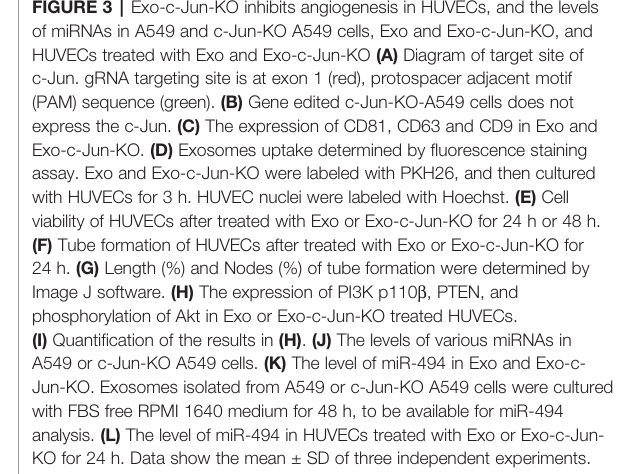
FIGURE 3 | Exo-c-Jun-KO inhibits angiogenesis in HUVECs, and the levels of miRNAs in A549 and c-Jun-KO A549 cells, Exo and Exo-c-Jun-KO, and HUVECs treated with Exo and Exo-c-Jun-KO (A) Diagram of target site of c-Jun. gRNA targeting site is at exon 1 (red), protospacer adjacent motif (PAM) sequence (green). (B) Gene edited c-Jun-KO-A549 cells does not express the c-Jun. (C) The expression of CD81, CD63 and CD9 in Exo and Exo-c-Jun-KO. (D) Exosomes uptake determined by fl uorescence staining assay. Exo and Exo-c-Jun-KO were labeled with PKH26, and then cultured with HUVECs for 3 h. HUVEC nuclei were labeled with Hoechst. (E) Cell viability of HUVECs after treated with Exo or Exo-c-Jun-KO for 24 h or 48 h. (F) Tube formation of HUVECs after treated with Exo or Exo-c-Jun-KO for 24 h. (G) Length (%) and Nodes (%) of tube formation were determined by Image J software. (H) The expression of PI3K p110 b , PTEN, and phosphorylation of Akt in Exo or Exo-c-Jun-KO treated HUVECs. (I) Quanti fi cation of the results in (H) . (J) The levels of various miRNAs in A549 or c-Jun-KO A549 cells. (K) The level of miR-494 in Exo and Exo-c- Jun-KO. Exosomes isolated from A549 or c-Jun-KO A549 cells were cultured with FBS free RPMI 1640 medium for 48 h, to be available for miR-494 analysis. (L) The level of miR-494 in HUVECs treated with Exo or Exo-c-Jun- KO for 24 h. Data show the mean ± SD of three independent experiments. *p < 0.05, **p < 0.01, and ***p